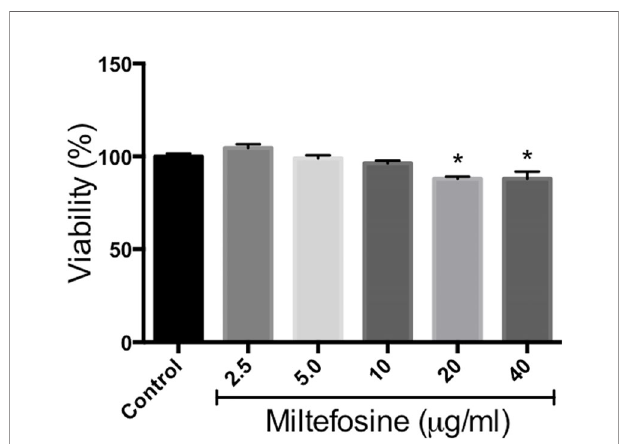
FIGURE 12 | Miltefosine citotoxicity assay. Monolayers of RAW cells were incubated for 24 h in the presence of 2.5, 5, 10, 20 or 40 m g/ml of miltefosine and cell viability was measured by neutral red method. * p <